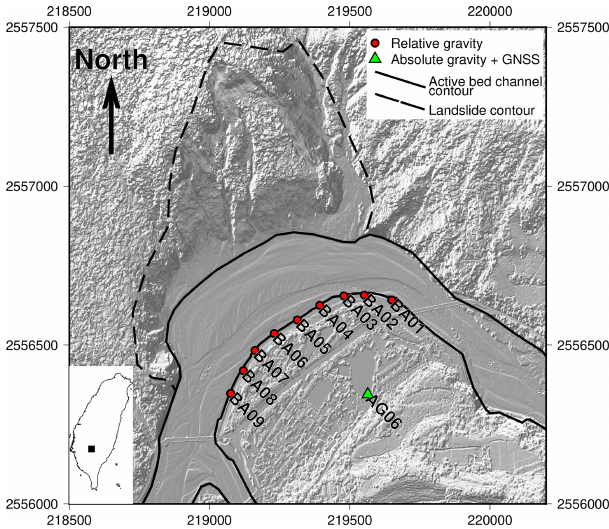
Figure 1. Shaded relief map of the study area. Absolute gravity measurements are performed only at AG06 while relative gravity measurements are performed at every site. The background image is the hill-shaded topography at half-meter resolution obtained by photogrammetry using an unmanned aerial vehicle (UAV). Map to the bottom left shows the study area in Taiwan. Axes are in meters in the TWD97 coordinate reference